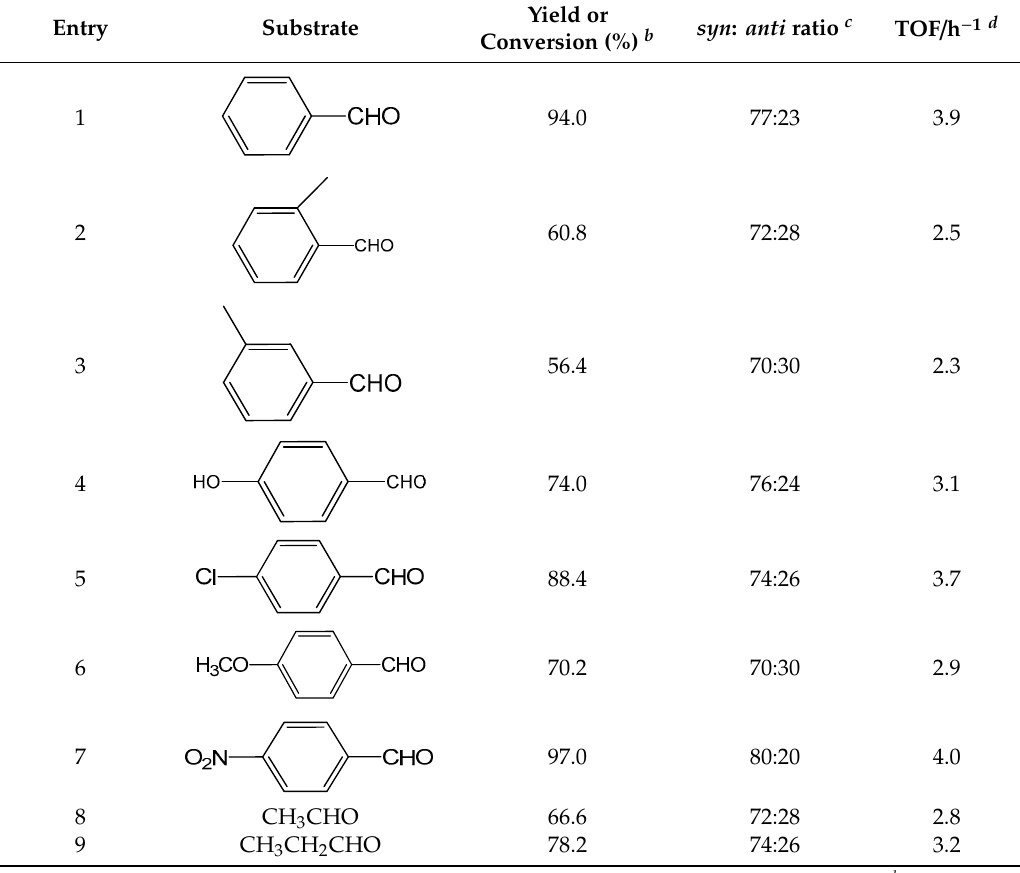
Table 4. Solvent-free nitroaldol condensation of different aldehydes and nitroethane catalyzed by 2 a .